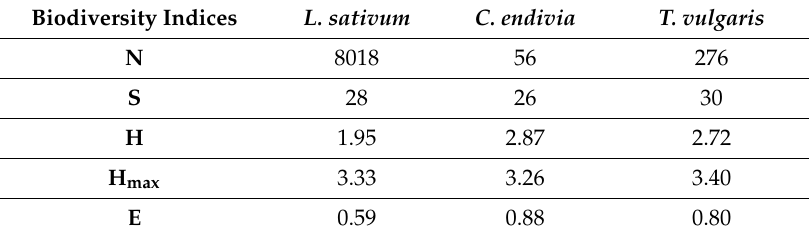
Table 1. Morphotype diversity index (Shannon index) of bacterial strains isolated from three plant species.